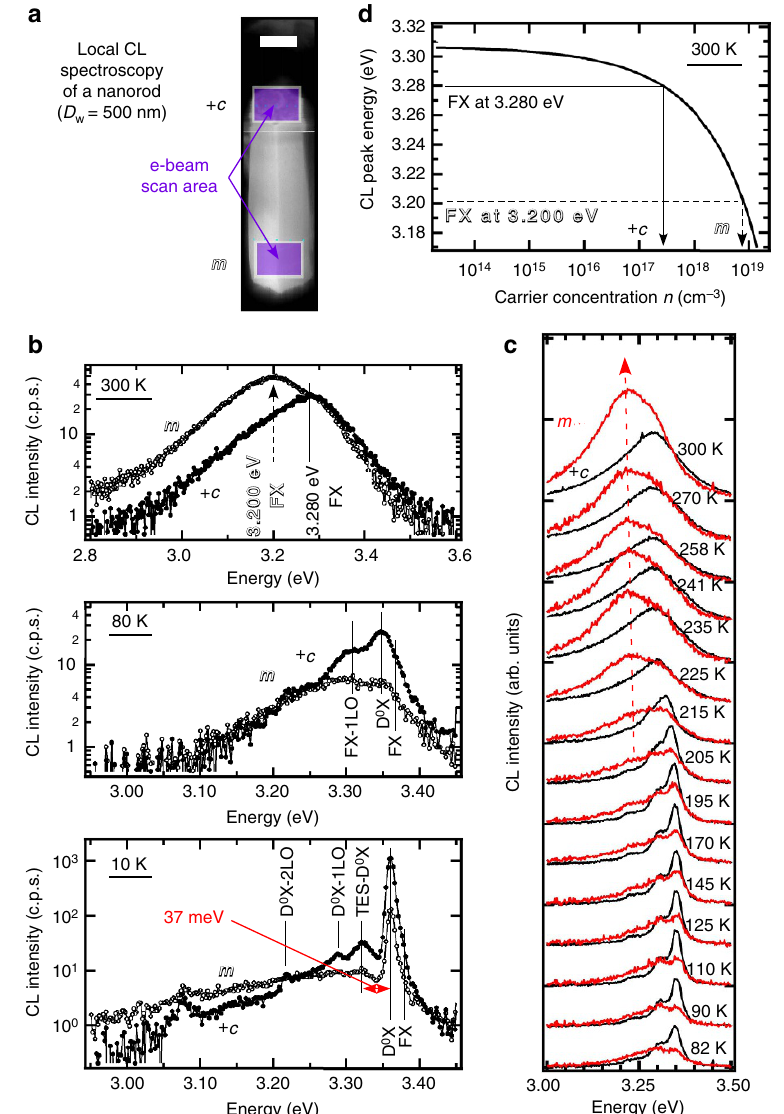
Figure 2 | Temperature-dependent high-resolution CL spectroscopy of a nanorod þ c top-plane and m side-plane. ( a ) Bird’s-eye view SEM image of a ZnO nanorod investigated by Area-CL spectroscopy. E-beam scan areas on þ c top-plane and m side-plane are indicated by transparent purple boxes. A horizontal scale bar indicates length of 0.5 m m. ( b ) Area-CL spectra on þ c and m planes at 300, 80 and 10K, probed by 3.0keV e-beam. CL peaks are assigned to free exciton (FX), neutral donor-bound exciton (D 0 X), its n th LO phonon replica (D 0 X- n LO) and its two electron satellite (TES-D 0 X). ( c ) Detailed temperature dependence of Area-CL spectra between 80 and 300K. Emergence of the redshifted FX peak is clearly observed. ( d ) Correlation between FX peak energy E FX (eV) and carrier electron concentration n (cm (cid:2) 3 ). Residual carrier concentrations n of þ c and m growth sectors are evaluated using their correlation: E FX ( n ) ¼ 3.307–8.39 (cid:3) 10 (cid:2) 15 n 2/3 -3.64 (cid:3) 10 (cid:2) 8 n 1/3 (ref.